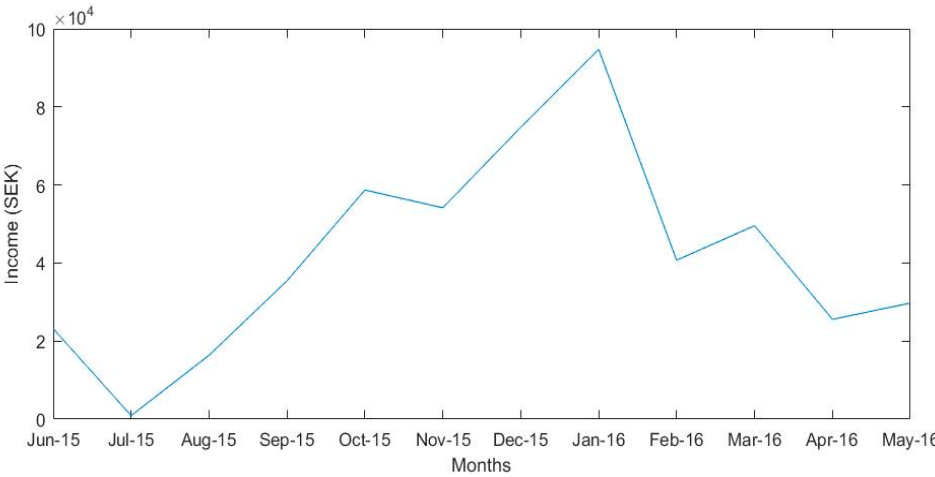
Figure 20. Monthly income stream of the wind farm.